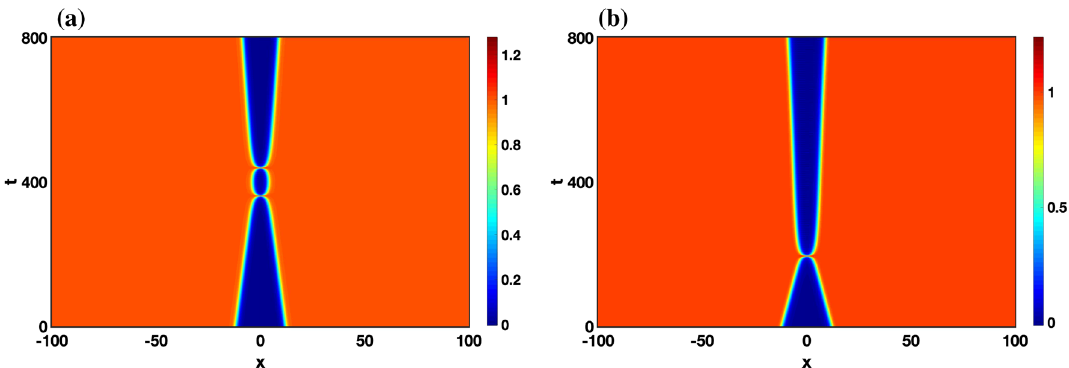
Fig. 13 Antikink-kink collisions for n = 1 with a v = 0 . 0228 – two-bounce and b v = 0 . 046 – one-bounce